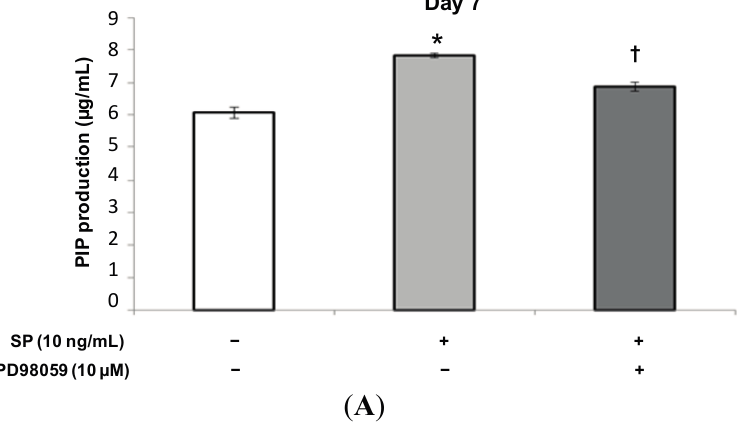
Figure 7. Effect of PD98059 on the production of PIP and OCN induced by SP. After the MSCs reached confluence, the culture medium was replaced with osteogenic medium containing SP (0 or 10 ng/mL), or SP (10 ng/mL) with the ERK 1/2 inhibitor, PD98059 (10 µM) and the cells were cultured for 7 ( A ) or 14 ( B ) days. * p < 0.05, SP (0 ng/mL) vs. SP (10 ng/mL), † p < 0.05, SP (10 ng/mL) vs. SP (10 ng/mL) with PD98059 (10